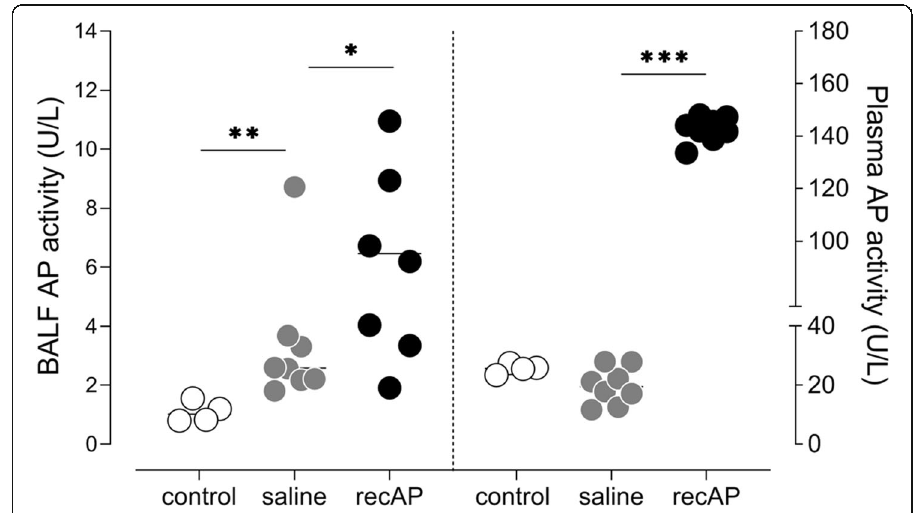
Fig. 7 Pulmonary and systemic AP activity in the two-hit lung injury model in rats. Abbreviations: AP, alkaline phosphatase; BALF, bronchoalveolar lavage fluid; recAP, recombinant alkaline phosphatase. * p value < 0.05; ** p value < 0.01; *** p value <